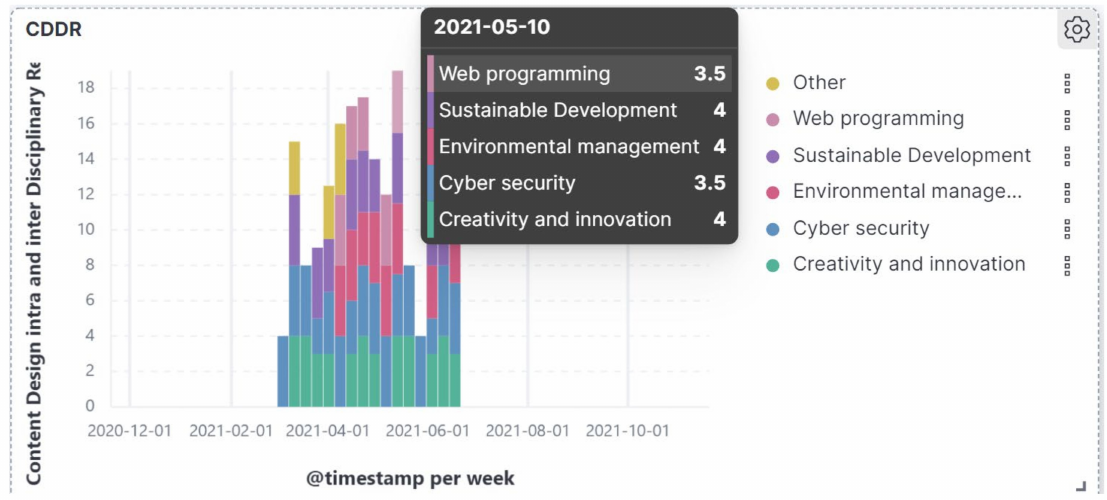
Figure 7. Responsive dashboard presenting Content Design Intra- and Interdisciplinary Relationship